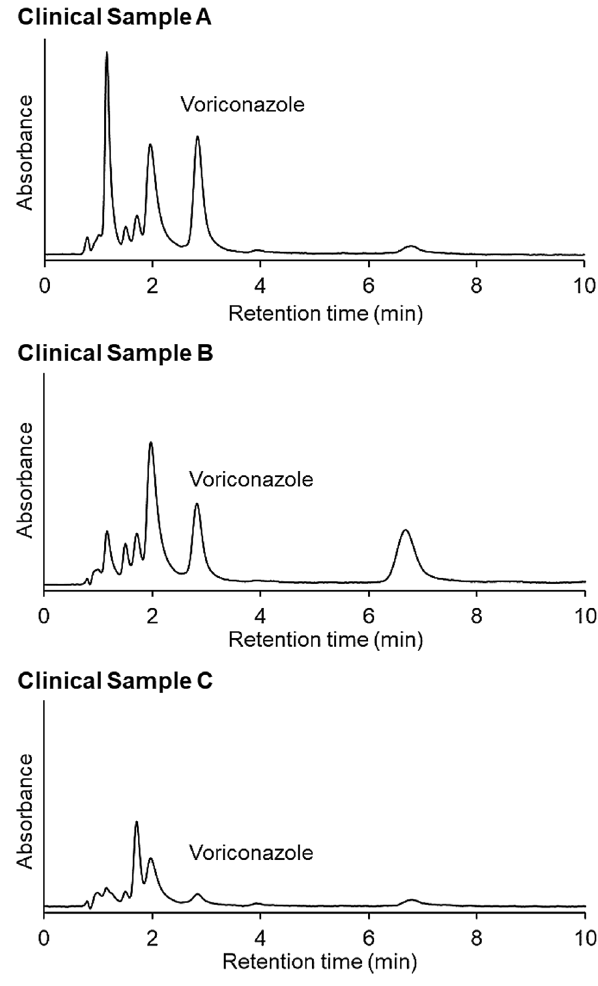
Figure 7. Chromatograms of clinical samples collected from patients who were administered voriconazole. Column: PN-0; mobile phase: 10 mmol/L CH 3 COONH 4 (pH 4.7); mobile phase flow rate: 1.0 mL/min; detection wavelength: 250 nm.